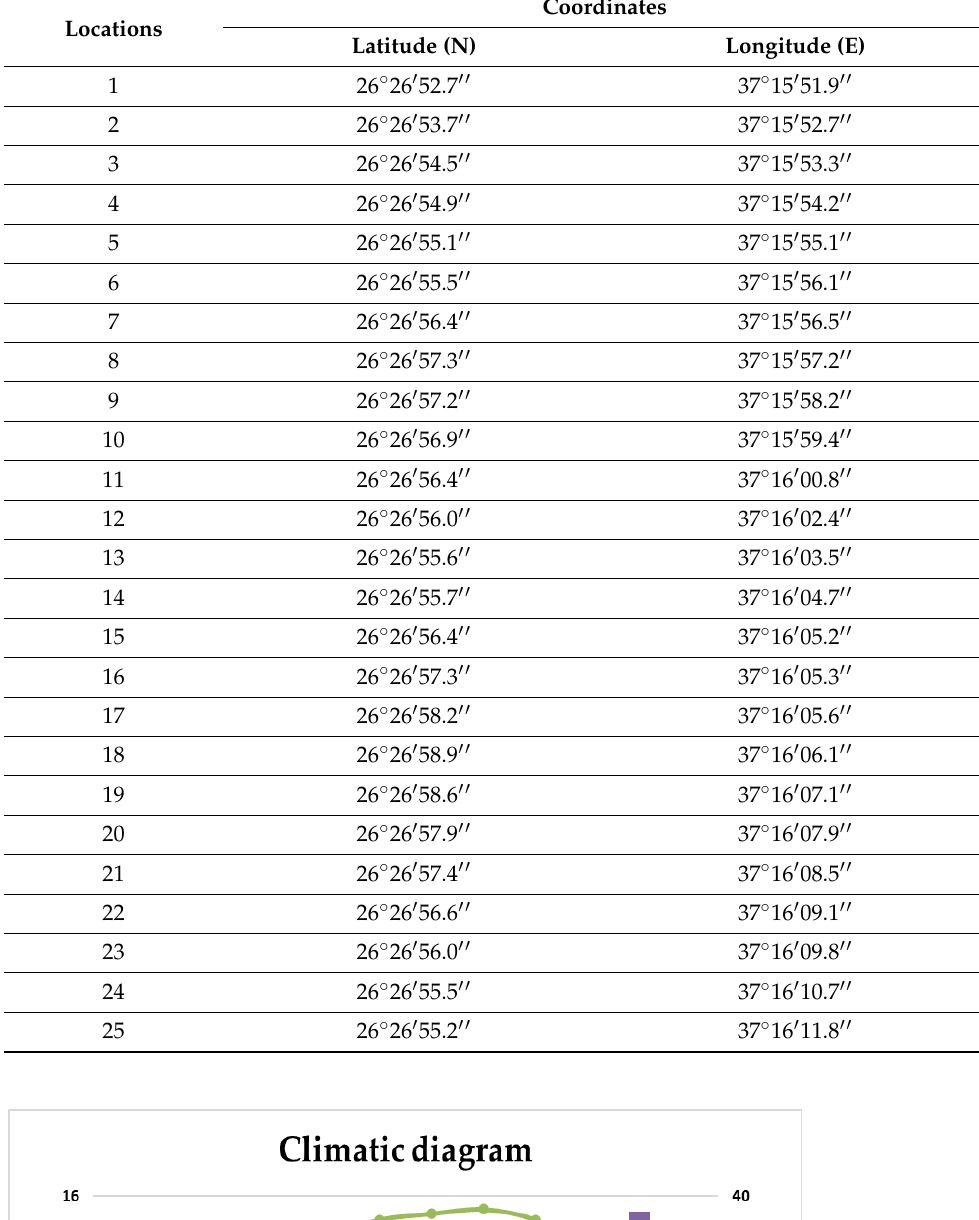
Table 1. Coordinates of 25 sampling sites in Jabal Al-Ward.